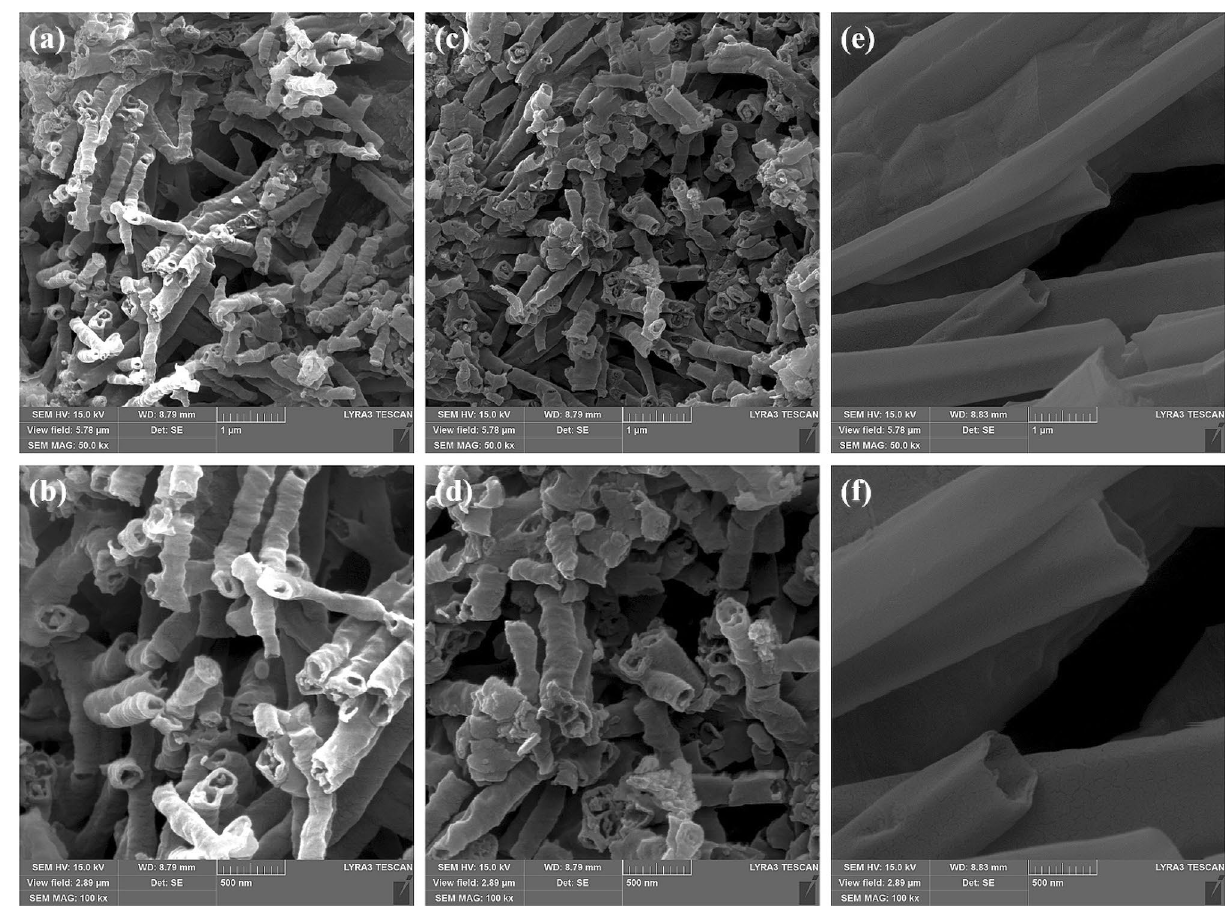
Figure 2. FE-SEM images of the as-prepared, pristine g-C 3 N 4 and Molybdenum impregnated g-C 3 N 4 samples: ( a , b ) pristine g-C 3 N 4 , ( c , d ) 5%Mo-CN, and ( e , f ) 15%Mo-CN